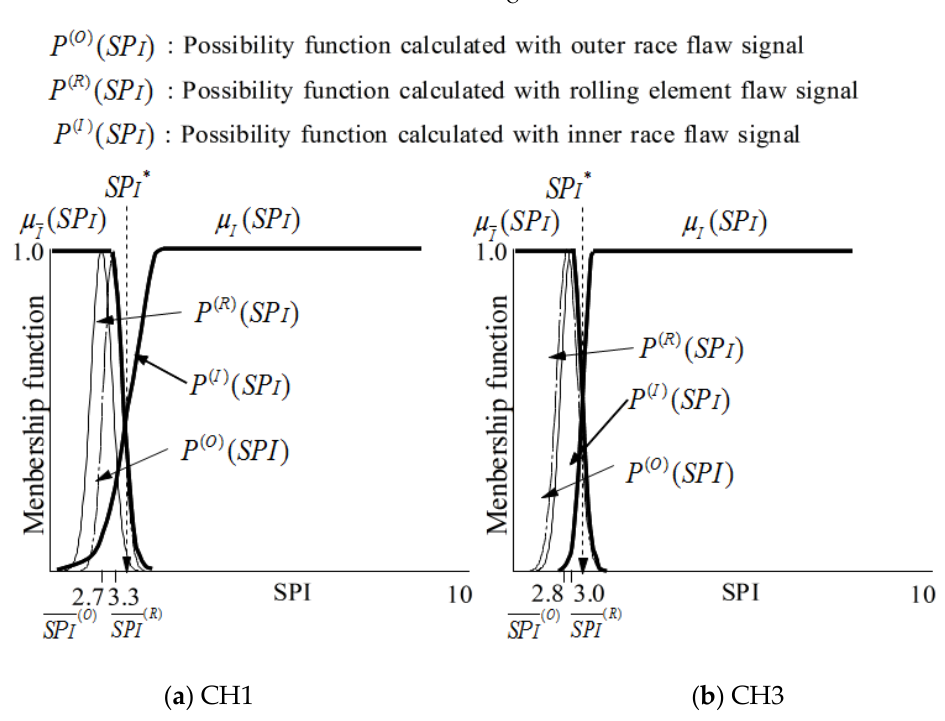
Figure 6. Membership functions 𝜇 I (𝑆𝑃I) and 𝜇 I̅ (𝑆𝑃I) for recognition of inner race flaw.